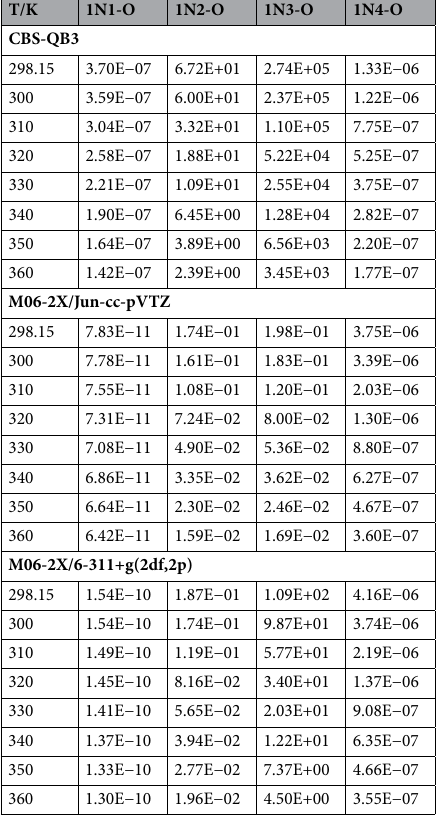
Table 6. Calculated half-life (in s) for all intermediates in 1,4-H shift of 3-hydroxyfuran-2(5H)-one at the CBS-QB3, M06-2X/Jun-cc-pVTZ, and M06-2X/6-311+g(2df,2p)